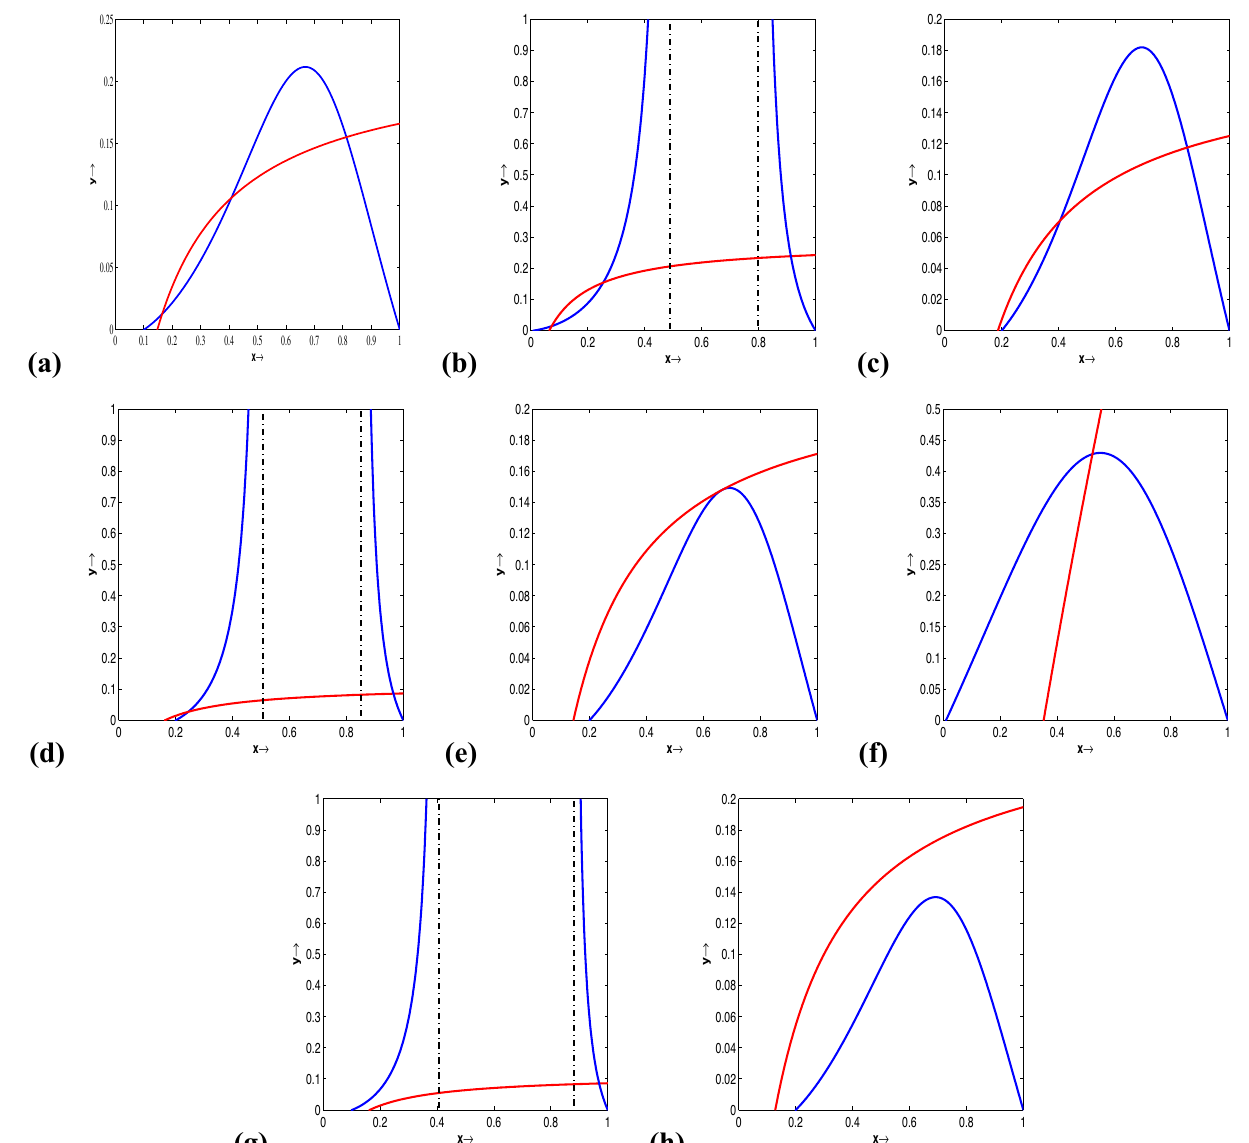
Figure 1. (Colour online) Strong Allee effect: prey-nullclines are identified by solid blue curves and, accordingly, predator-nullclines are recognized by solid red curves. ( a ) For β = 10 ,the two nullclines cross thrice, then there exist three positive intersections. ( b ) For l = 0.01, β = 7.8, a = 10.5, b = 5.2, d = 0.3 , in this case we have three interior equilibrium points. ( c ) Two equilibrium points exists for l = 0.2 ; β = 9 ; a = 7.5 ; b = 4.1 ; d = 0.7 . ( d ) For l = 0.2, β = 5, a = 10.5, b = 5.2, d = 0.3 , in this case we obtain the existence of two equilibrium points. ( e ) one equilibrium point exists for l = 0.2 ; β = 10.1267155062337 ; a = 7.5 ; b = 4.1 ; d = 0.7 , ( f ) one equilibrium point for l = 0.01, β = 1, a = 0.5, b = 0.9, d = 0.3 . ( g ) One equilibrium point for l = .1, β = 5, a = 10.5, b = 5.2, d = 0.3 . ( h ) For l = 0.2 ; β = 10.7 ; a = 7.5 ; b = 4.1 ; d = 0.7 , there exists no interior equilibrium